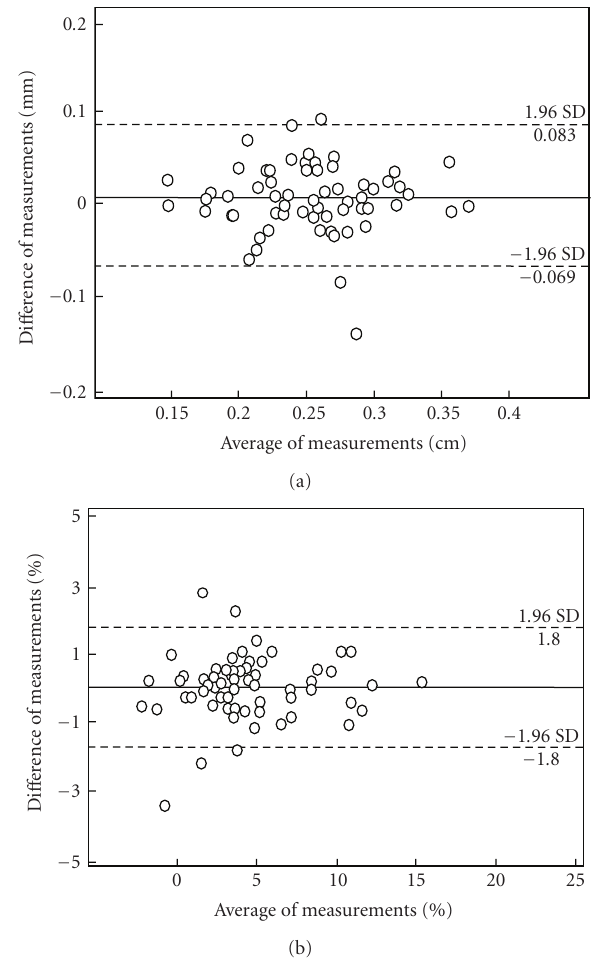
Figure 8: Bland and Altman plots of repeated measurements. The horizontal axis reports the average of two consecutive measure- ments, the vertical axis their di ff erence. The dotted lines represent 1 . 96 standard deviation from the mean. (a) Diameter; (b) FMD.